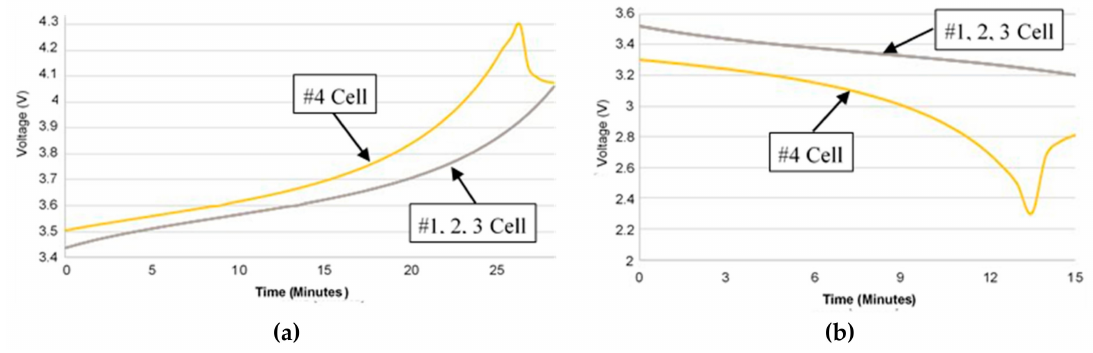
Figure 11. Demonstration of BMS functions: ( a ) 25 A continuous charging; ( b ) 35 A continuous discharging.